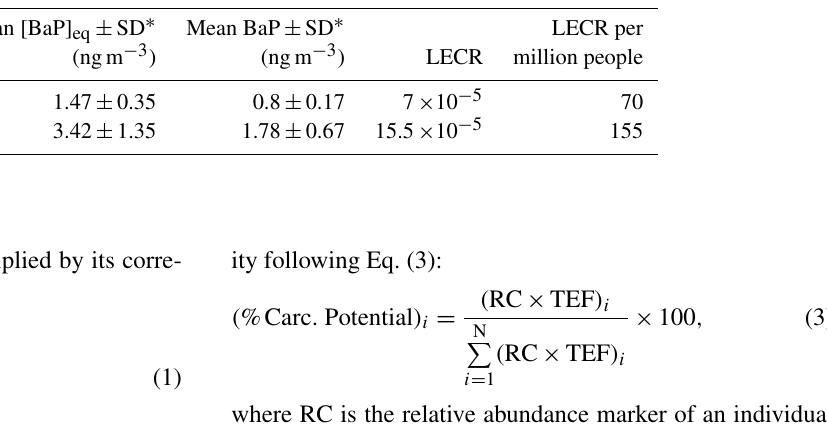
Table 2. Mean concentration of BaP eq , BaP and LECR assessment for Beijing and